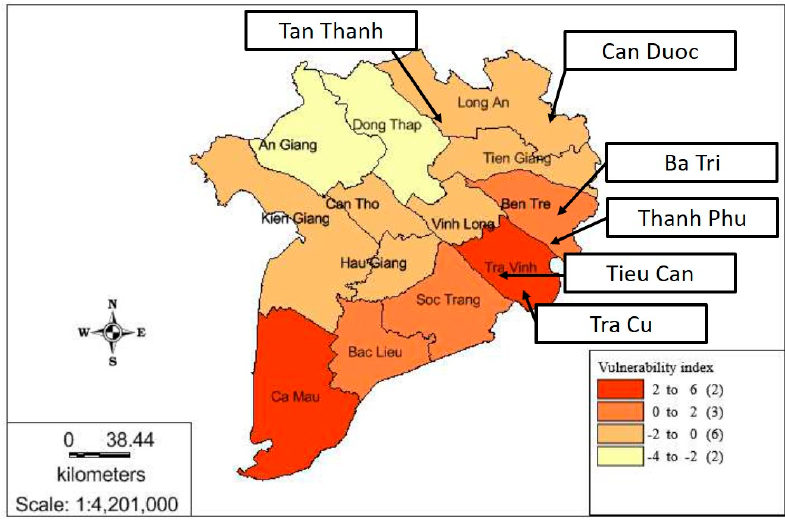
Figure 1. Map of the study areas. Source: Thuy and Anh [17].